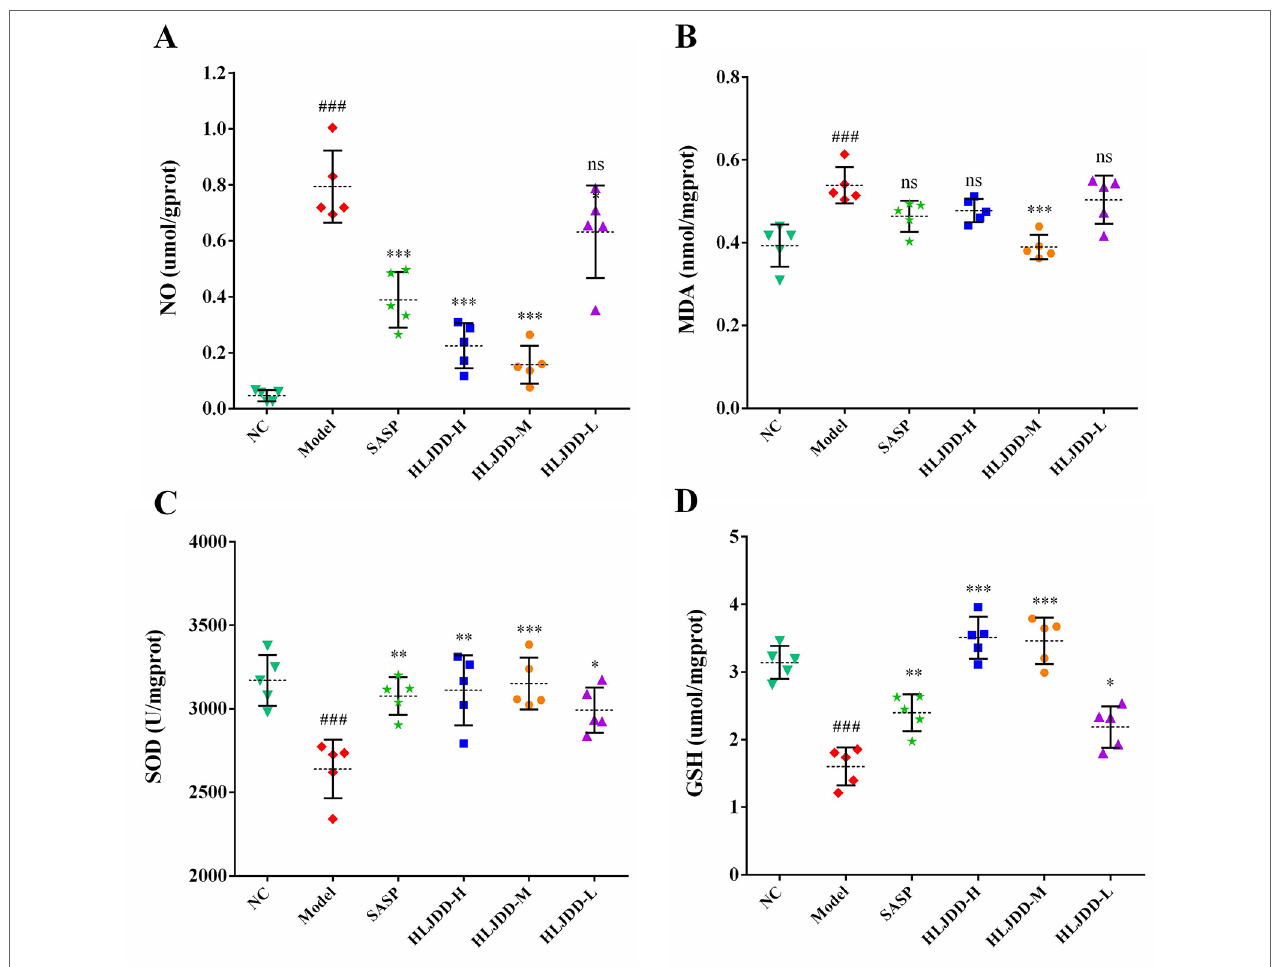
FIgURE 6 | Antioxidant effect of HLJDD on DSS-induced UC. Levels of NO (A) , MDA (B) , SOD activity (C) , and GSH (D) in colon homogenate. Data are expressed as the mean ± SD, n = 5 per group. ### p < 0.001 vs. NC group; * p < 0.05, ** p < 0.01, *** p < 0.001 vs. model group. ns, no significant.